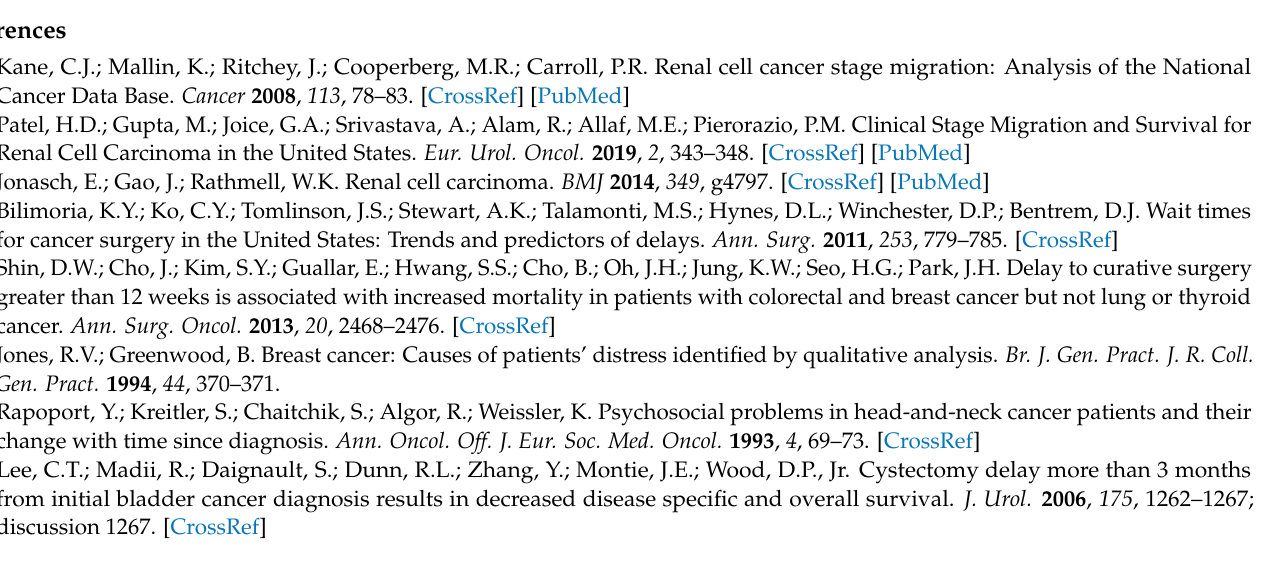
factors influencing TTS among all patients. Table S2: Clinical characteristics of T1a patients stratified by TTS. Table S3: Univariable Cox regression for DFS and OS among T1a patients. Table S4: Clinical characteristics of T1a patients stratified by TTS and adjusted by IPTW. Table S5: Clinical characteristics of T1b patients stratified by TTS. Table S6: Univariable Cox regression for DFS and OS among T1b patients. Table S7: Clinical characteristics of T1b patients stratified by TTS and adjusted by